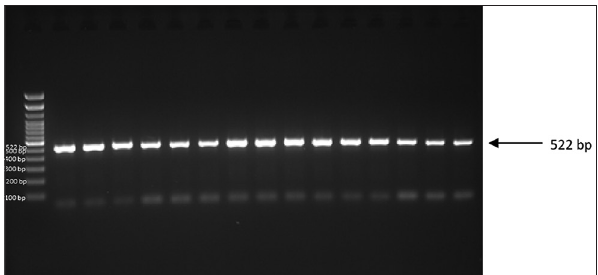
Figure-1: Leptin gene amplification on Madrasin